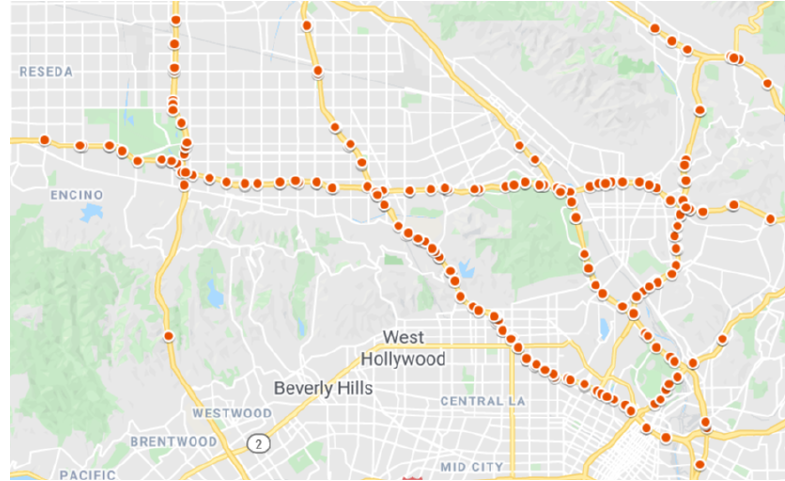
Figure 5. The dataset was collected from the highway of Los Angeles County (METR-LA) from 1 March 2012 to 30 June